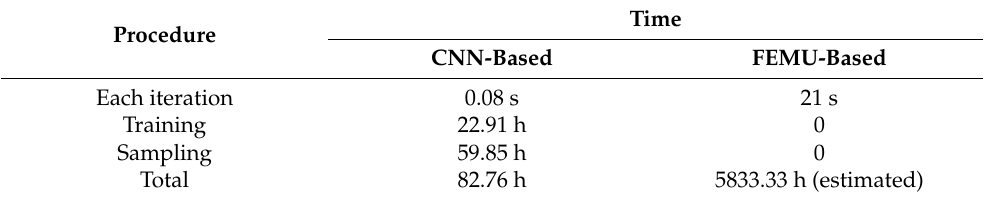
Table 3. Comparison of running time between CNN- and FEMU–based